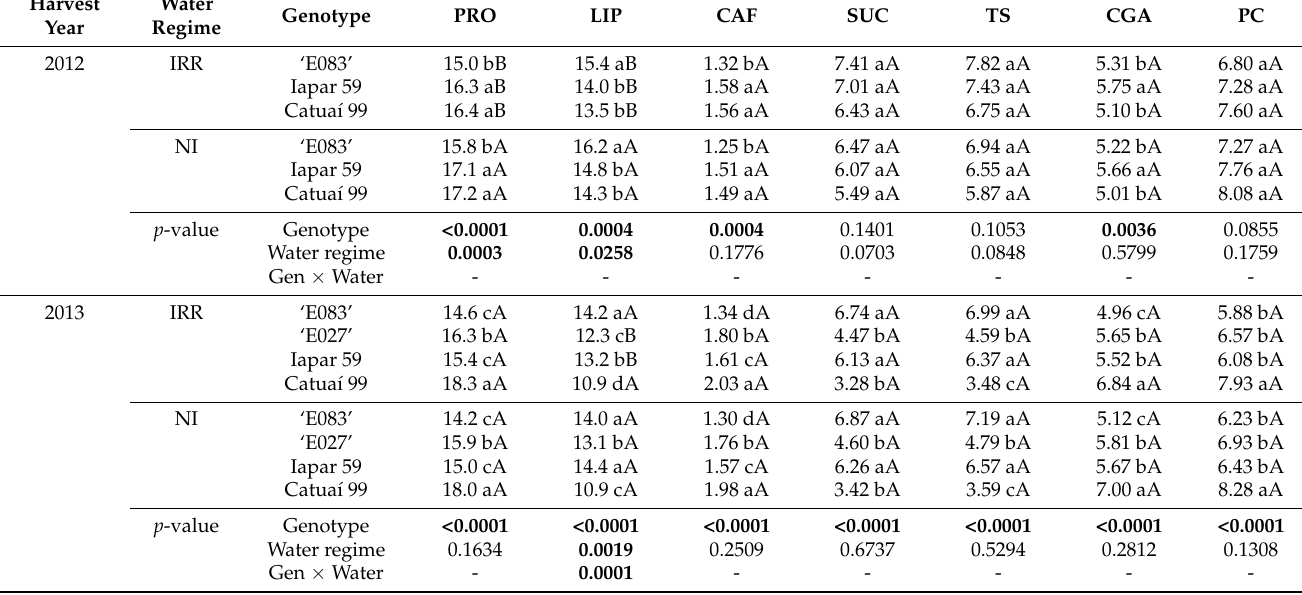
Table 3. Chemical contents (% of dry matter): PRO (proteins), LIP (lipids), CAF (caffeine), SUC (sucrose), TS (total soluble sugars), CGA (total chlorogenic acids), PC (phenolic compounds) of two harvests (2012 and 2013) analyzed in four genotypes of Coffea arabica cultivated under two water regimes (irrigated—IRR; not irrigated—NI). Estimated means and p -values are shown ( n = 4), where “-“ indicates that the model reduction and fitting were applied. When significant, p -value is marked in bold. Lower-case letters compare genotype effects within each water regime, whilst the upper-case letters compare water regime effects within each genotype, always separately for each harvest year.